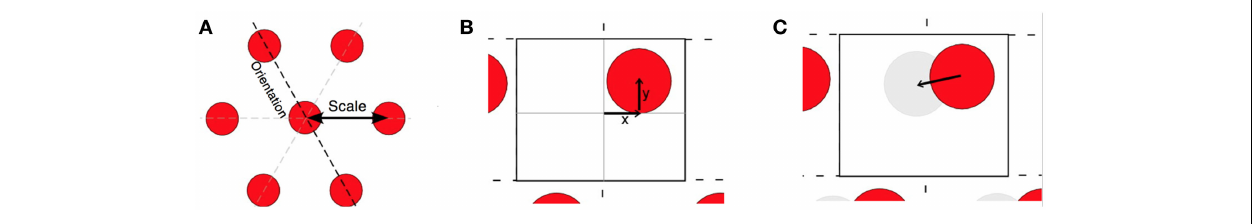
FIGURE 1 | (A) Idealized spatial excitability pattern of a single grid cell, illustrating grid scale, and orientation. (B) Closer view of the excitability map showing the boundaries of a single rectangular tile.The phase of one cell is